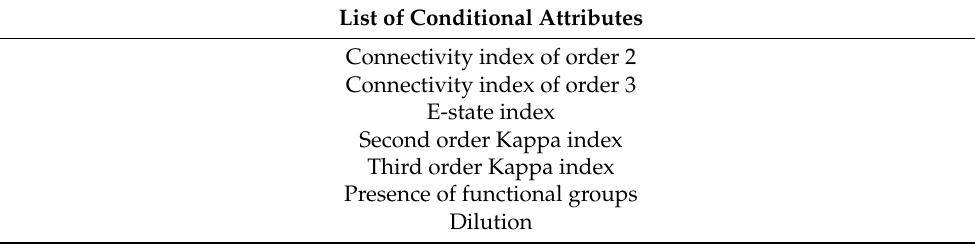
Table 2. Conditional attributes that affect